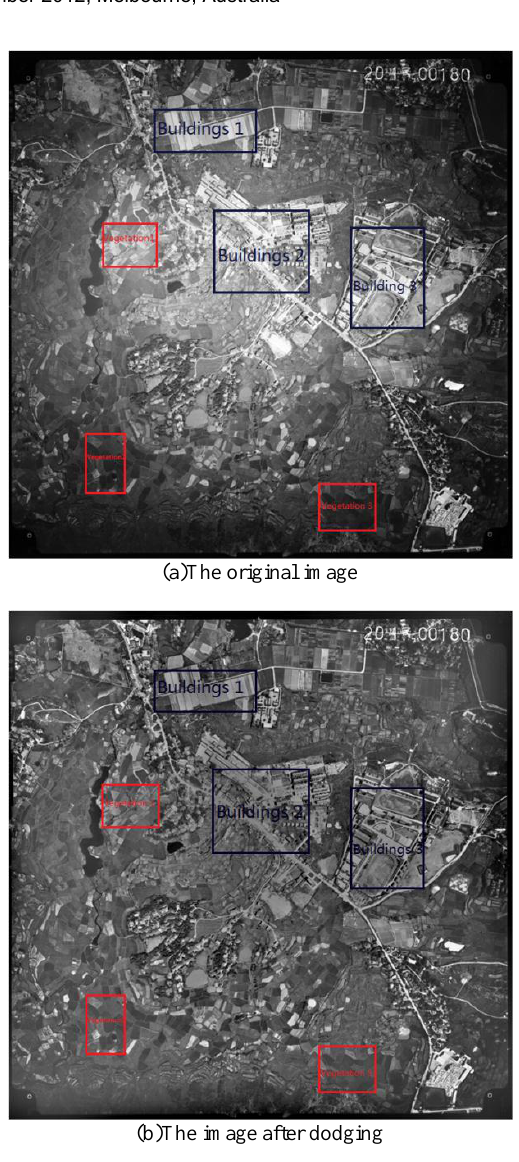
Figure 6. The original image and the image after dodging